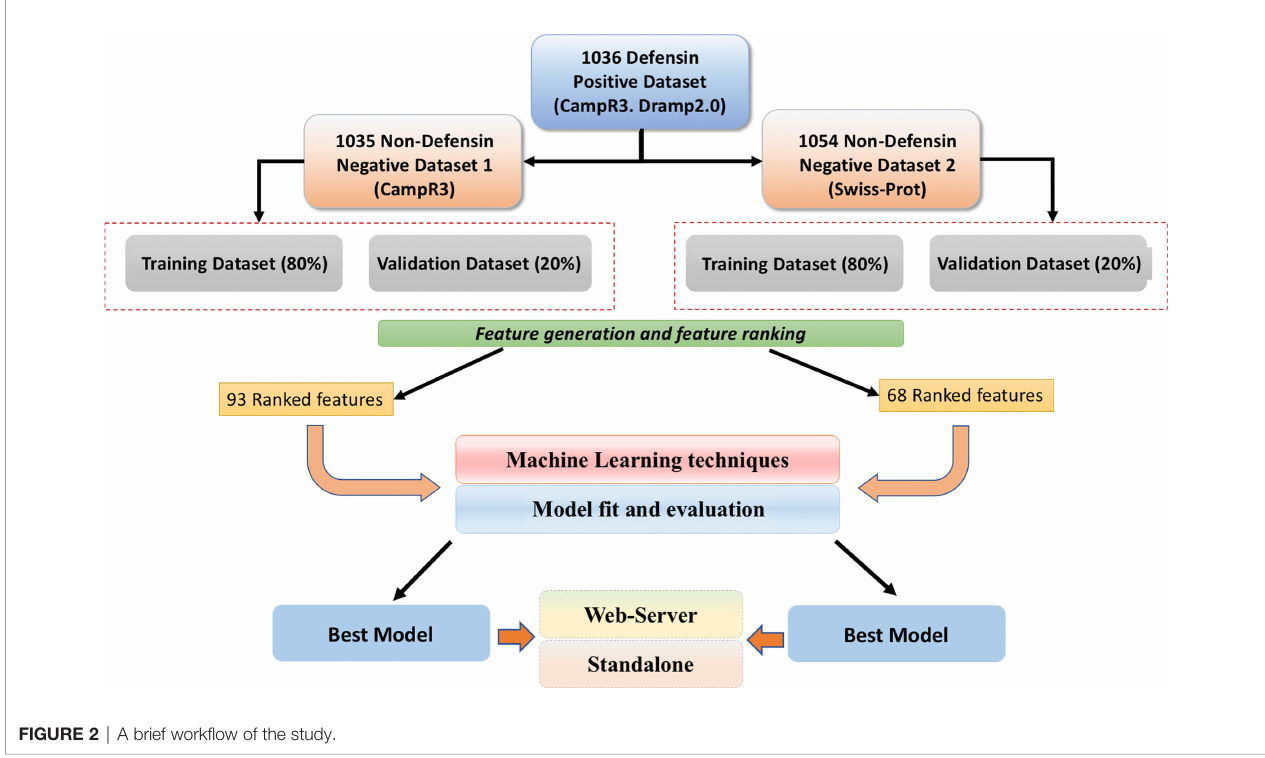
FIGURE 2 | A brief work fl ow of the